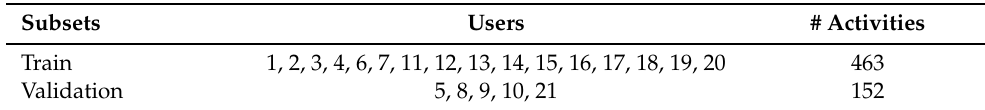
Table 5. Participant distribution for each subset using the hold-Out method.